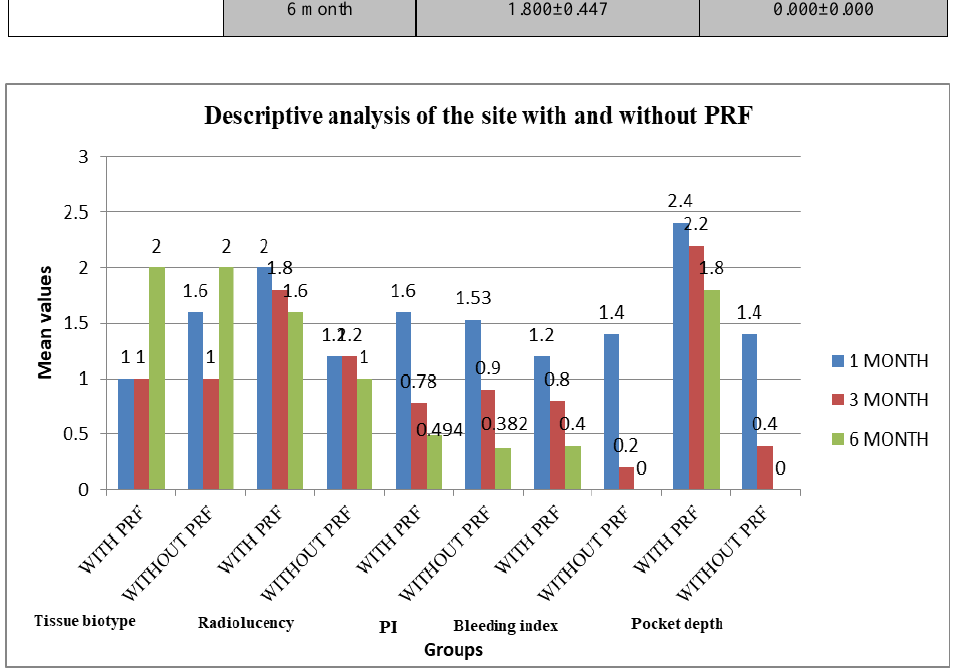
Fig. 1. Representing the mean and standard deviation of the two grouping